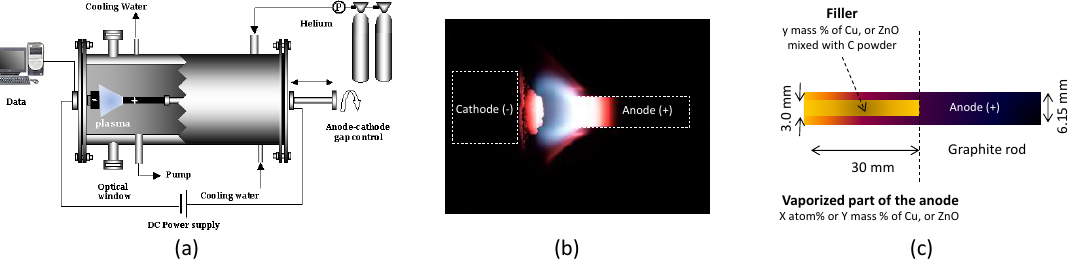
Figure 1. Arc discharge set-up: ( a ) schematic; ( b ) photography of the luminous plasma zone created between the anode and the cathode and ( c ) anode composition.